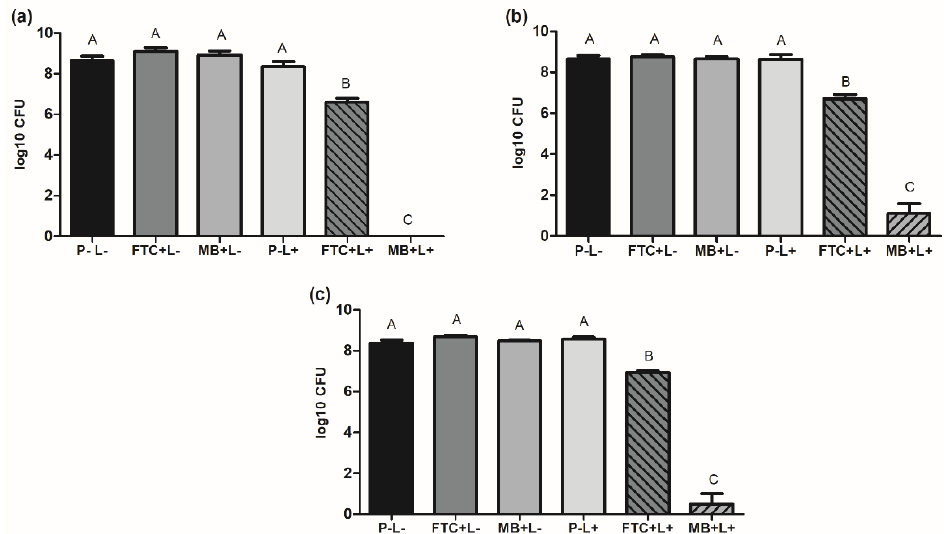
Figure 1. Means and standard deviation of viable cells of A. baumannii (log 10 CFU) in planktonic growth for the following groups: absence of photosensitizer and light (P-L-), FTC without light (FTC+L-), MB without light (MB+L-), absence of photosensitizer with light (P-L+), FTC with light (FTC+L+), and MB with light (MB+L+). ( a ) A. baumannii reference strain (ATCC 19606). ( b ) A. bau- mannii A2 clinical strain. ( c ) A. baumannii A4 clinical strain. ANOVA and Tukey test: different letters represent statistical difference between the groups ( p ≤ 0.05 ).